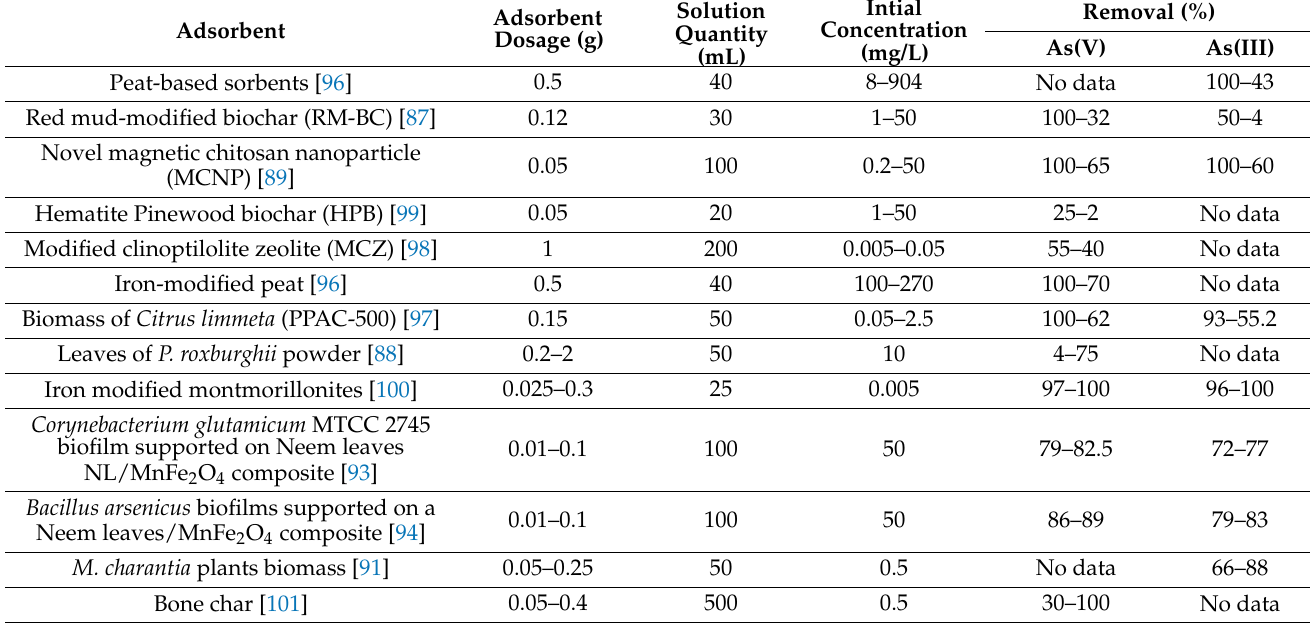
Table 2. Some studies related to initial As concentration and adsorbent dosage impact on As adsorption capacity.